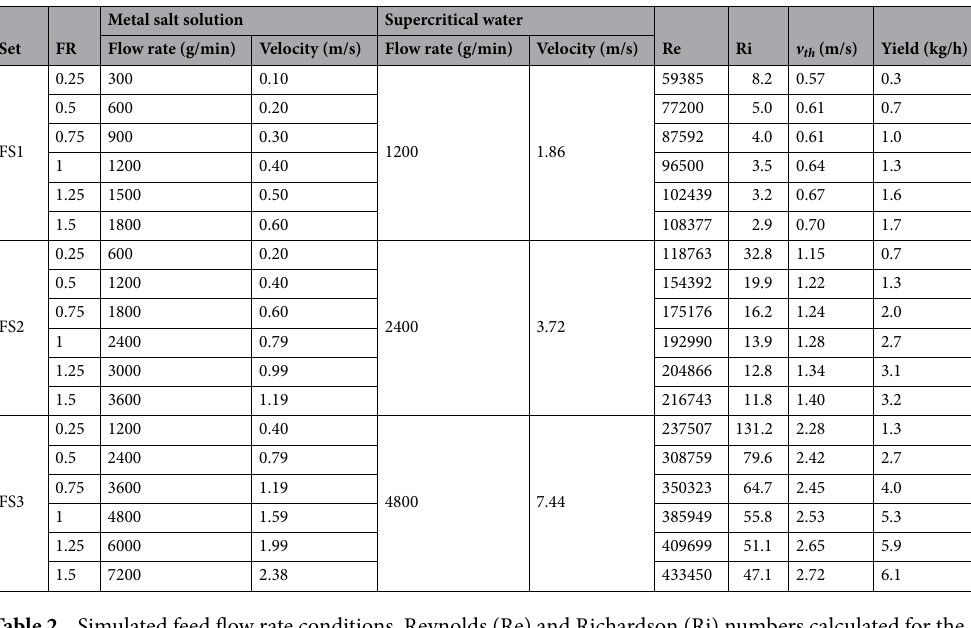
Table 2. Simulated feed flow rate conditions, Reynolds (Re) and Richardson (Ri) numbers calculated for the reaction mixture at the end of the inlet section, predicted threshold velocity and ceria yield.